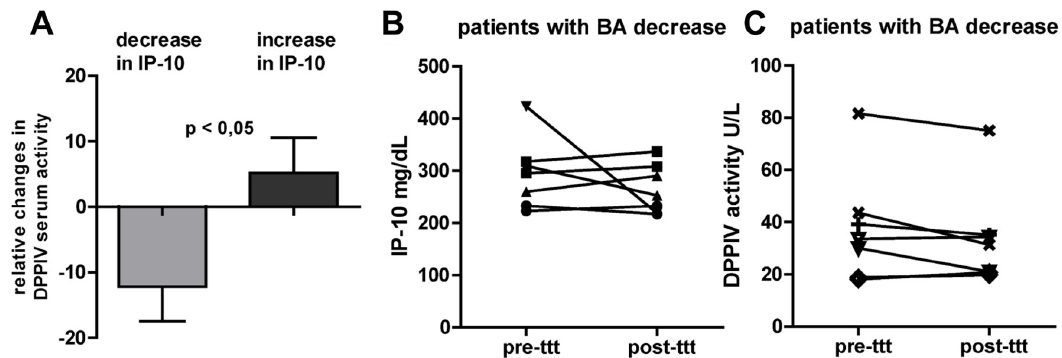
Fig 5. Validation cohort with cholestatic liver disease (PBC/PSC) and biliary drainage (n = 16). A) Patients with relative decrease/increase in IP-10 had significantly relative decrease/increase in DPPIV serum activity. B-C) Seven representative patients with highest decrease in BA and the corresponding (B) serum IP-10 and (C) DPPIV activity over